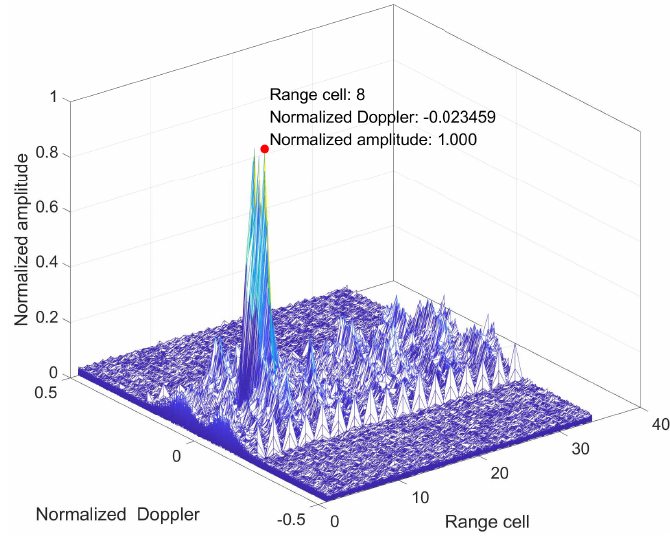
Figure 5. Range–Doppler image of IPIX clutter